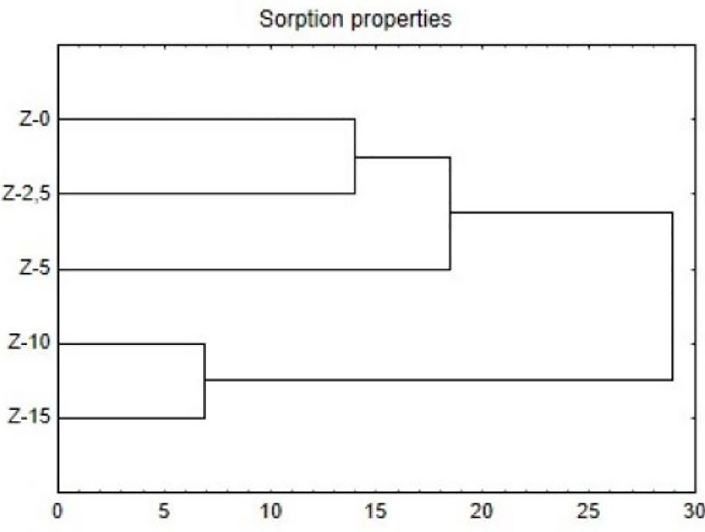
Fig 1. Dendrogram of the HCA results for sorption properties (CEC, TEB, and V) of the examined soil substrates.